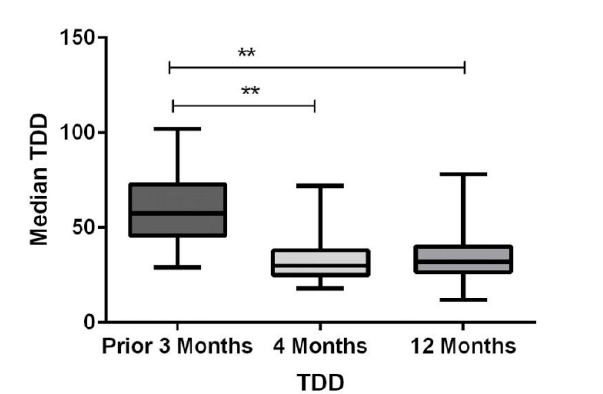
Figure 2: Median total daily dose of insulin with duration of CSII therapy